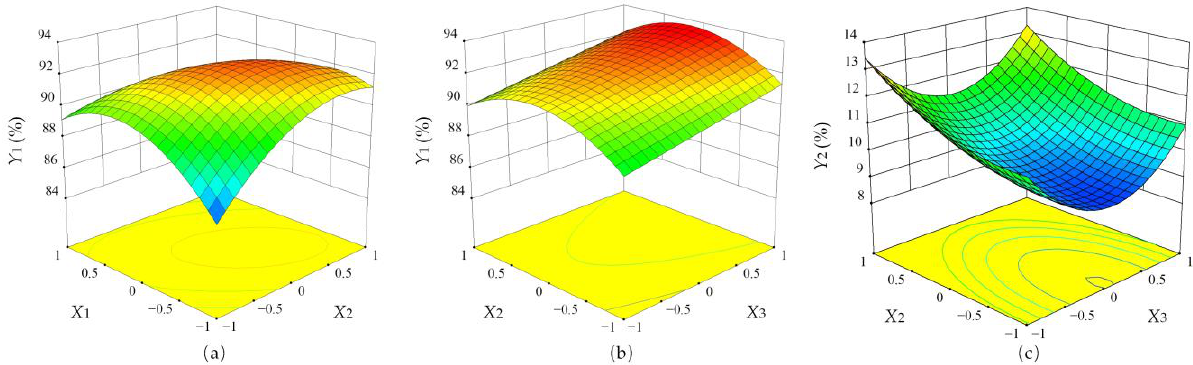
Figure 11. Influence of various factors on the RPF collector performance. ( a ) X 3 = 1950 r/min; ( b ) X 1 = 5 km/h; ( c ) X 1 = 5 km/h. ( b ) X 1 = 5 km/h; ( c ) X 1 = 5 km/h.